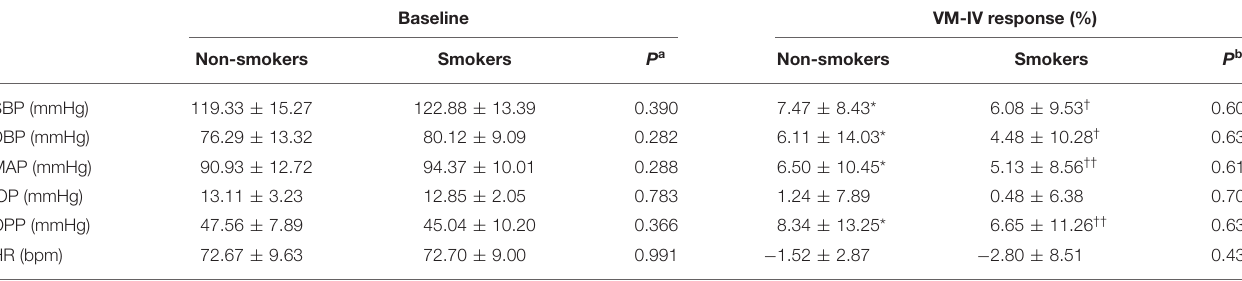
TABLE 2 | Systemic parameter and other ocular findings before and after VM-IV in non-smokers and